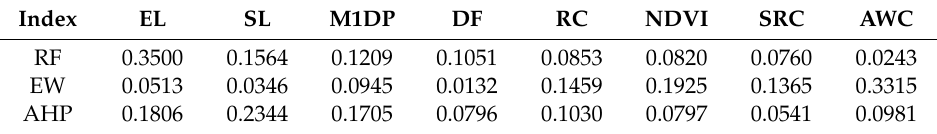
Table 4. Index weights determined by RF, entropy and analytic hierarchy